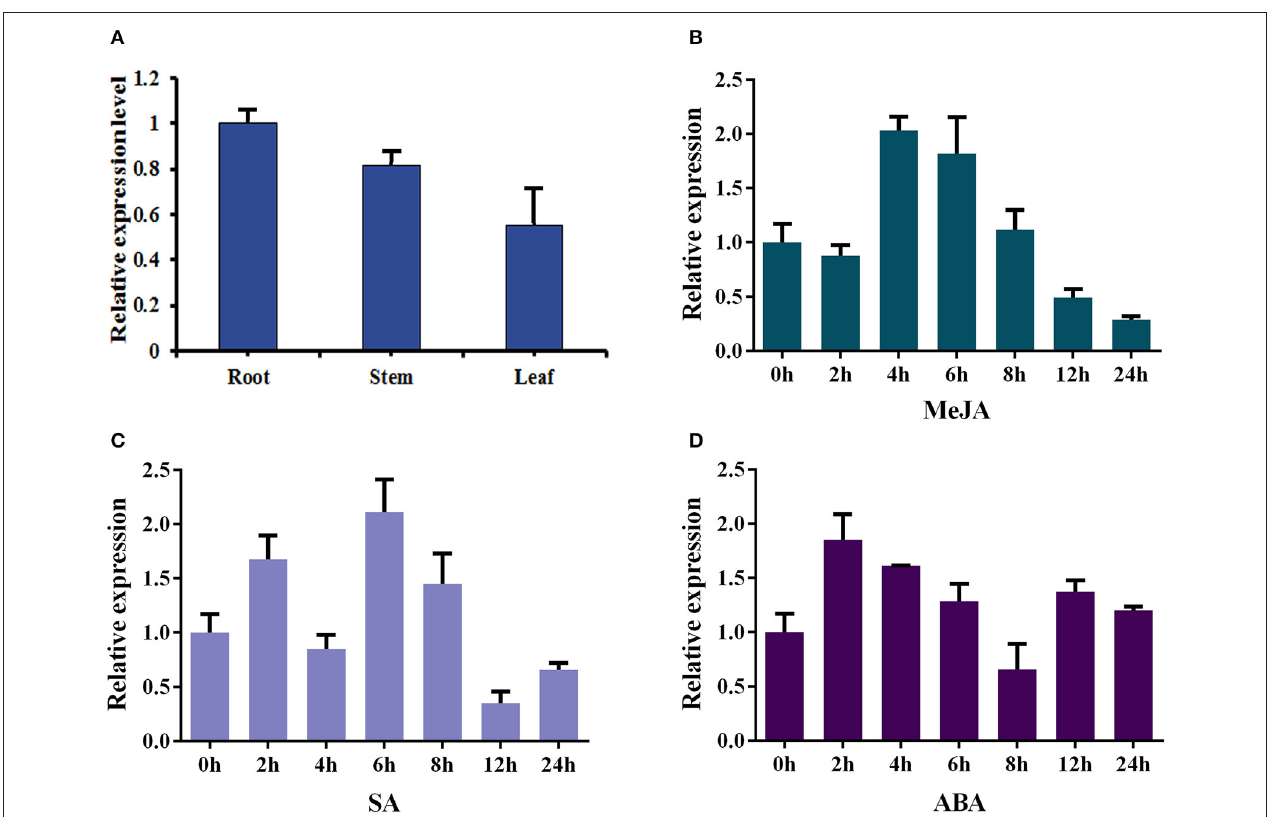
FIGURE 3 | Expression profiles of Ii049 in different I. indigotica tissues (A) and under the induction of phytohormones [MeJA (B) , SA (C), and ABA (D)